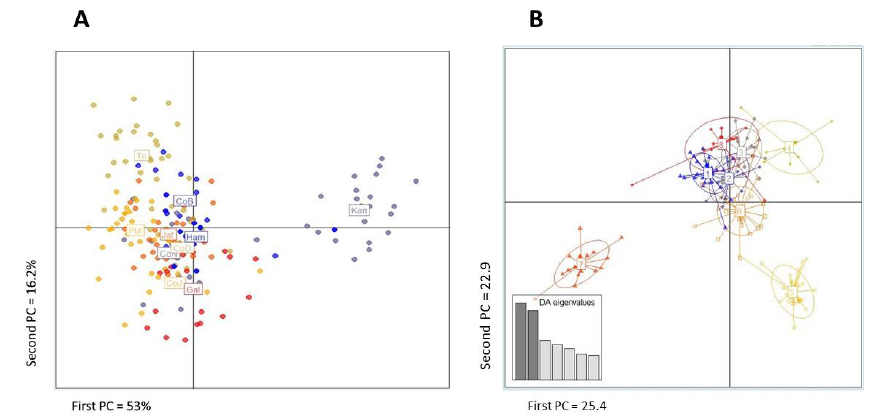
Figure 4. ( A ) Principal component analysis (PCA) of the original data in ten collections from Sri Lanka. Each dot corresponds to an individual mosquito. The amount of variance explained by each PC is indicated on each axis. The first two principal components account for 53% (X-axis) and 16.2% (Y-axis) of the total variance. ( B ) Discriminant Analysis of principal components (DAPC) displayed as eight genetic clusters. The first and second principal components account for 25.4 + 22.9 = 48.3 of the total variation. Visual clusters of points of the same color in Figure 3A correspond roughly to those in Figure 3B.